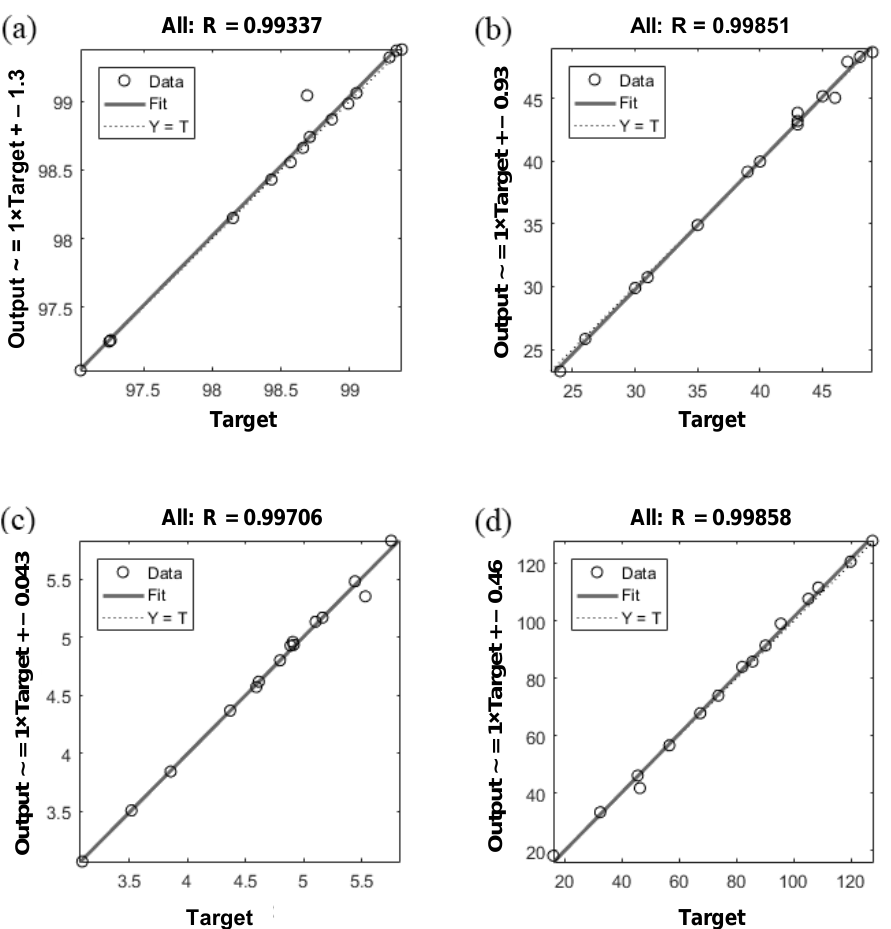
Figure 13. Validation curves in ANN models for prediction of ( a ) Id 2 , ( b ) SRH, ( c ) UPV, and ( d ) UCS.